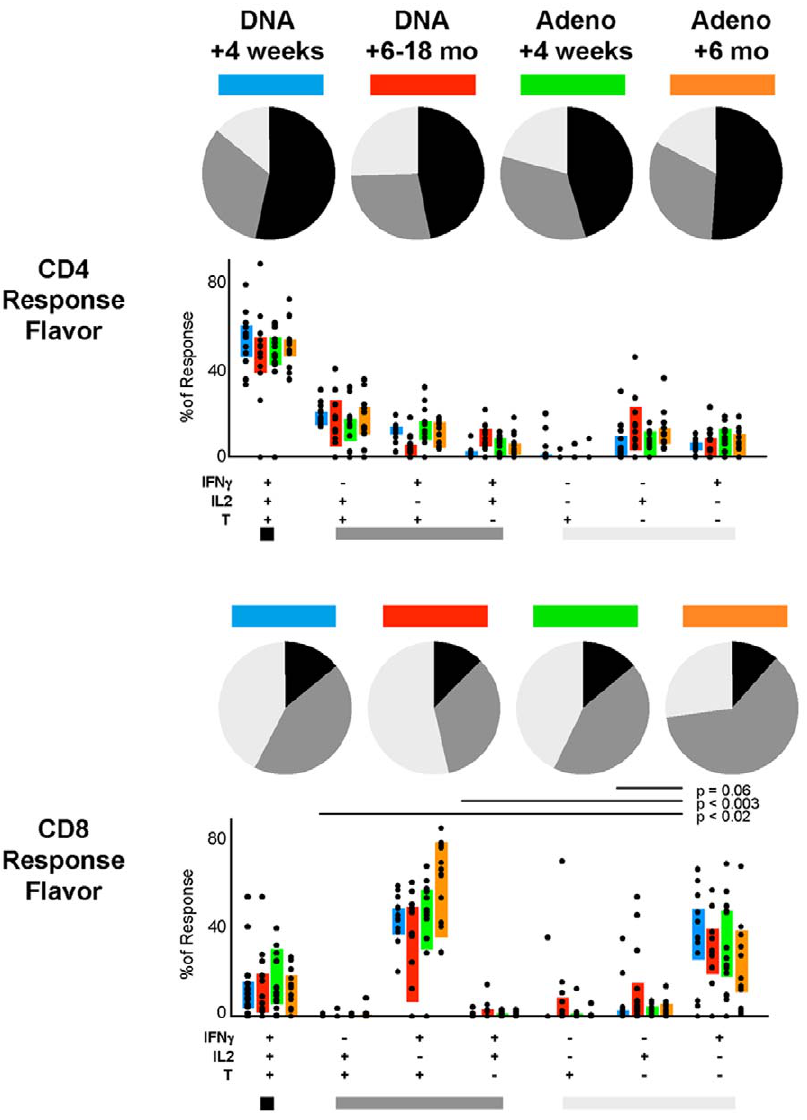
Figure 3. Function of vaccine-induced T cells. The quality of the vaccine-elicited CD4 or CD8 T cell response is characterized by the proportion of cells making every possible combination of the three measured cytokines. The bar charts show the individual data points and IQR for four time points following immunization. Pie charts show the average proportion of the CD4 or CD8 vaccine-specific T cell response that is polyfunctional (black), producing two functions (medium grey), or is monofunctional (light grey). The memory time point had a significantly different quality of CD8 T cell response than earlier time points (SPICE permutation analysis).